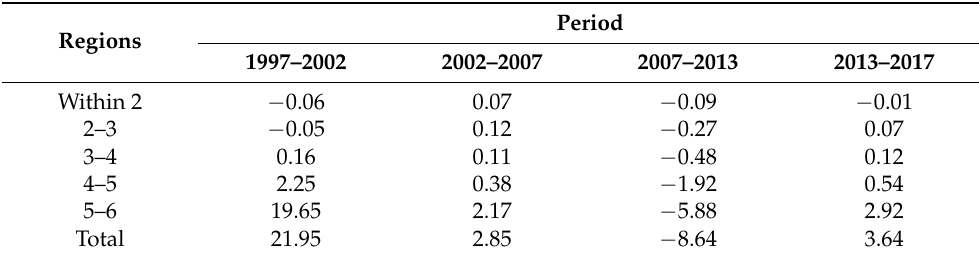
Table 4. The area changepercentage of impervious surfaces in each separated region and the study